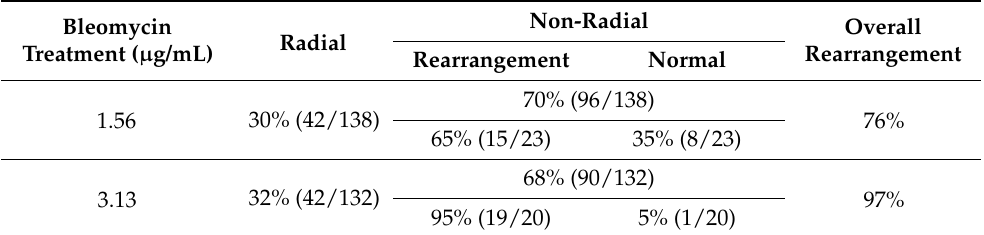
Figure 2. Example karyotypes of ( A ) radial formations (indicated by arrows) and ( B ) non-radial formations containing chromosomal rearrangements. CHO-DUK cells were treated with 1.56 µg/mL or 3.13 µg/mL of bleomycin and incubated for 24 h before being harvested and used for karyotyping. Table 1. Ratio of chromosomal rearrangements determined by the karyotyping of CHO-DUK cells treated with bleomycin. The numbers in parentheses are the number of analyzed images per given total samples.